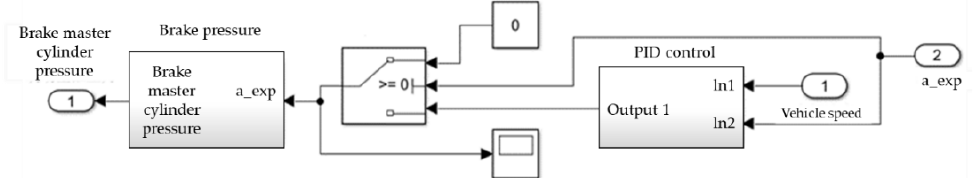
Figure 7. PID control model of braking system.